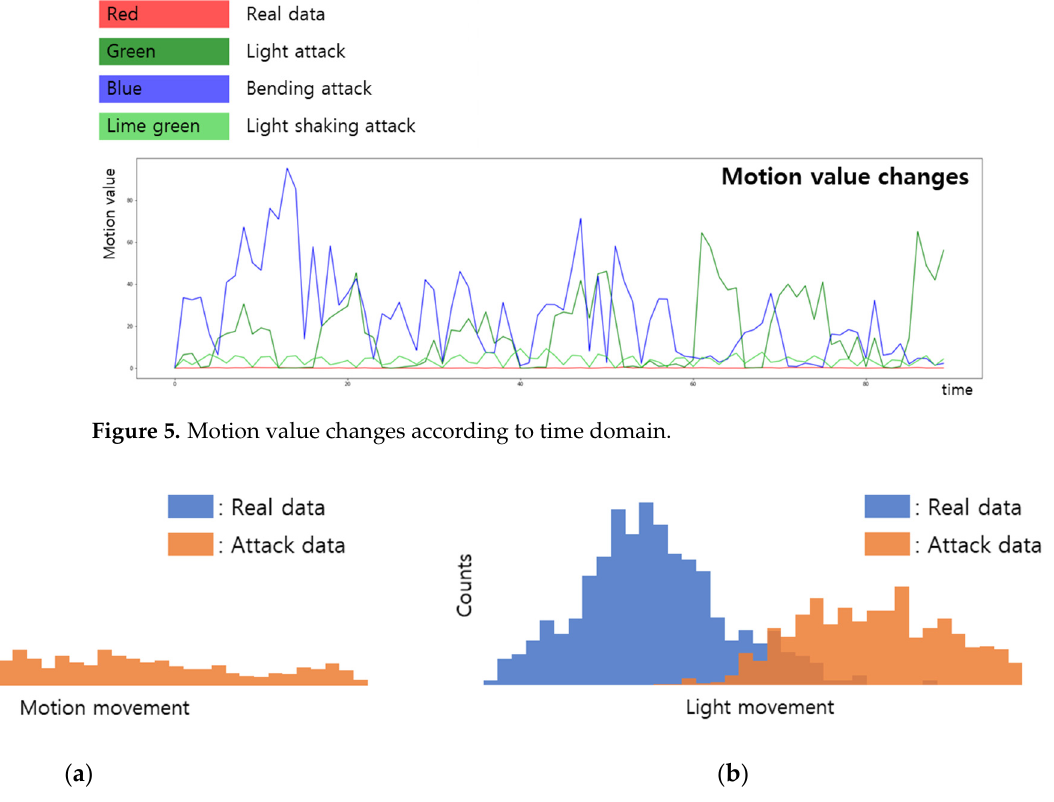
Figure 6. Genuine/Imposter plot of ( a ) motion and ( b ) light movement.